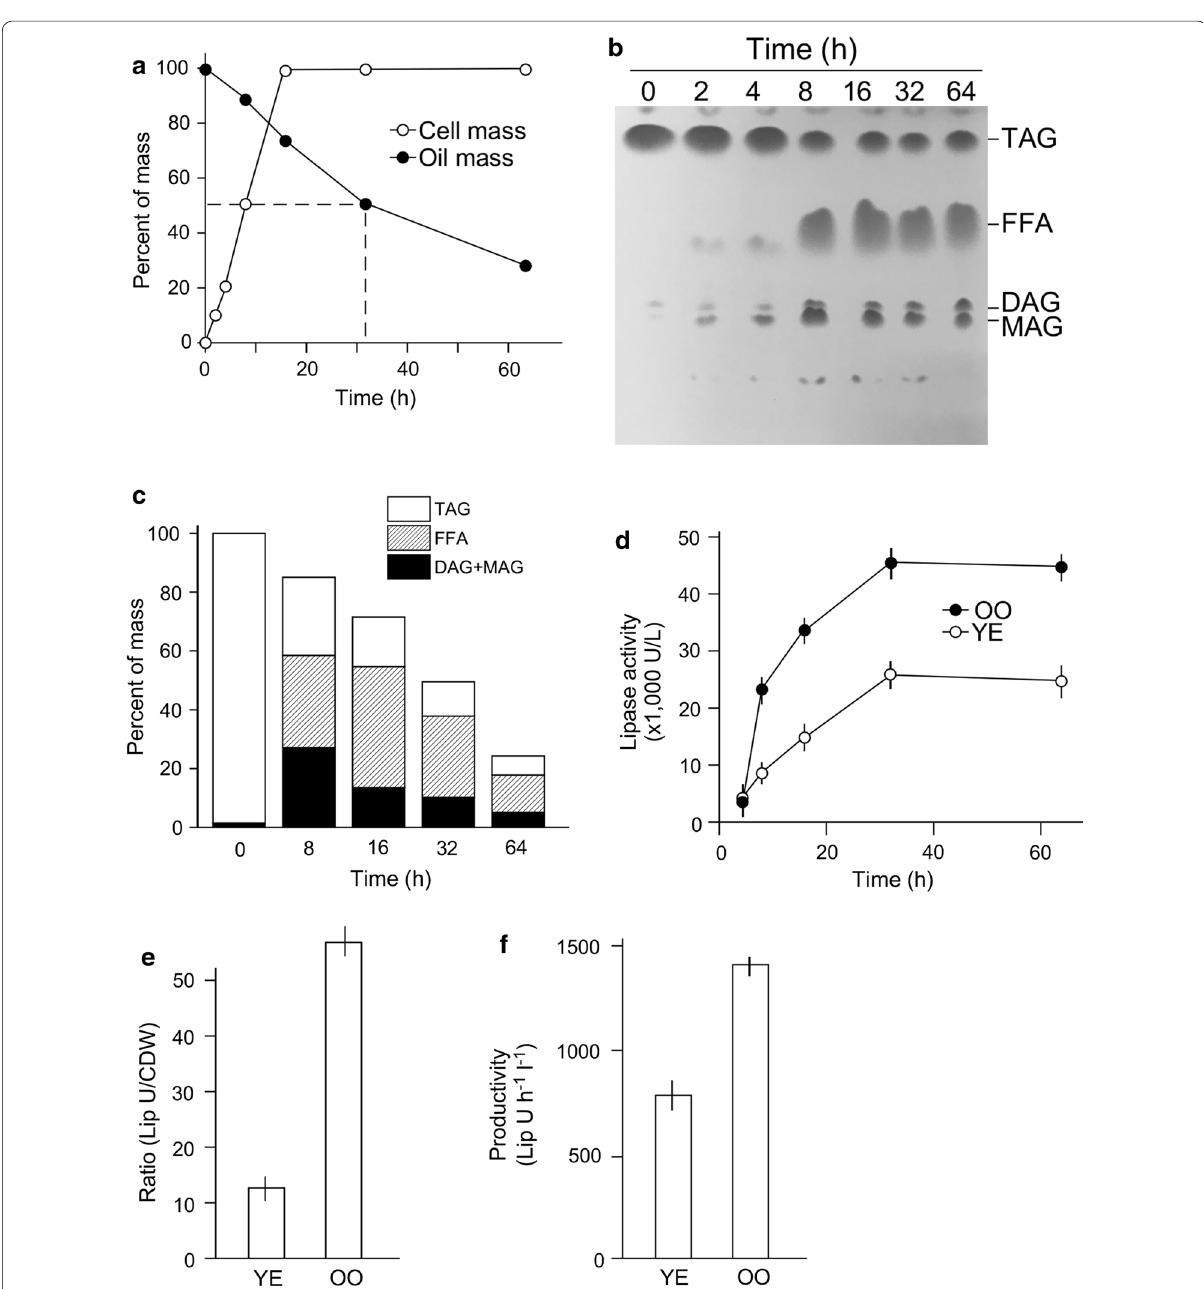
Fig. 3 Characterization of olive oil consumption by ZS6. a Gravimetric analysis of oil assimilation by ZS6. X- and Y-axes indicate the time (h) and percent of cell mass (closed circle) and oil mass (open circle). b Thin-layer chromatographic analysis of oil residues extracted from supernatant of ZS6 cultures at various time points indicated. Equal amount of hexane extracts is loaded on TLC plate. Separated fractions of compounds are deduced based on their molecular weight determined using MS analysis. TAG triacylglycerol, FFA free fatty acid, DAG diacylglycerol, MAG monoacylglycerol. c Changes of lipid compositions in culture. Total lipids are mainly consistent of TAG (open rectangle), FFA (stripped rectangle), DAG and MAG (black rectangle). d ZS6 lipase activity in MS medium supplemented with olive oil and YE. X- and Y- axes indicate time (h) and lipase activity (U L − 1 ). Closed and open circles indicate cells in medium supplemented with olive oil (OO) and YE, respectively. e Efficiency of lipase production per unit of cell mass. Ratio of maximum lipase activity in U and CDW. f Productivity of lipase activity in U per hour per